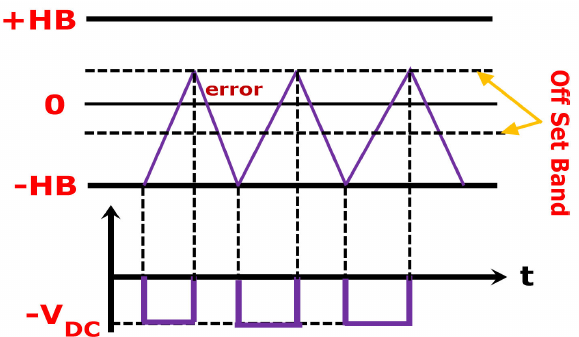
Figure 6. Analysis of offset hysteresis band current controller with negative inverter output [48].